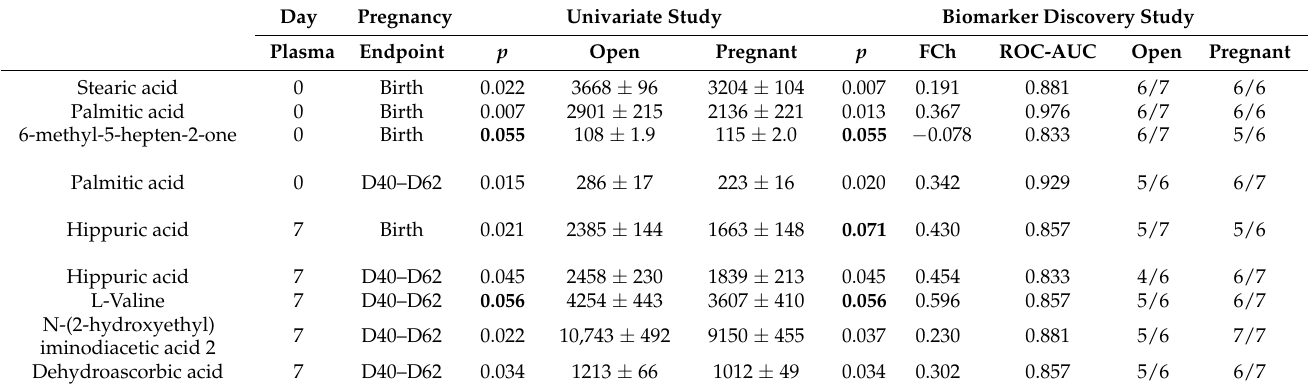
Dehydroascorbic acid Open and pregnant: concentrations in arbitrary units (Univariate study) and samples correctly identified/total samples (Biomarker discovery study). p values: Kruskal-Wallis test or GLM procedure with Bonferroni correction p < 0.05 (Univariate study) and t -test (Biomarker discovery study) significant differences: p < 0.05. Tendency (bold): 0.05 < p < 0.072. FCh = Log Fold change.